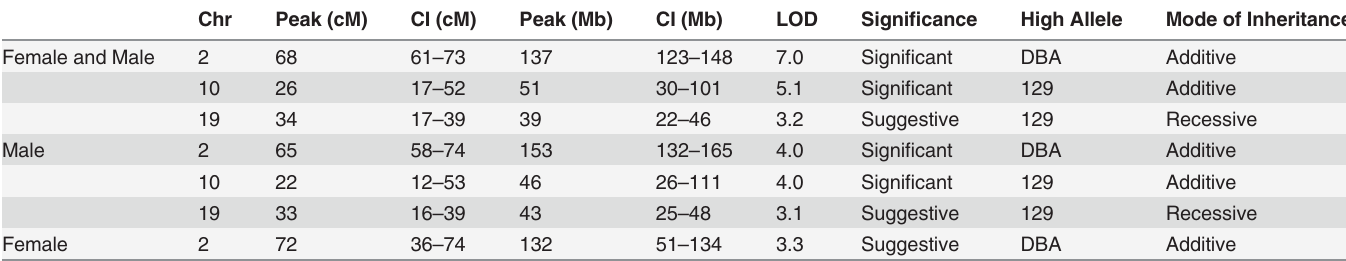
Table 2. QTL for atherosclerosis at the aortic arch identi fi ed by genome-wide single